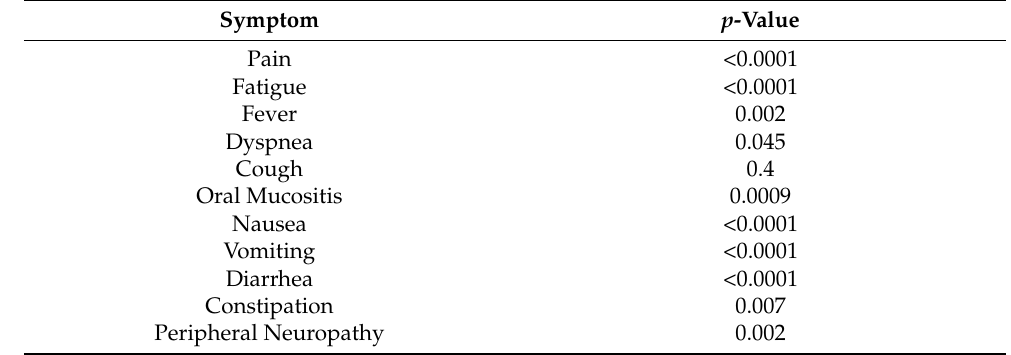
Table 3. Association between symptom change and QLQ-C30 change (responsiveness). (Abbrevia- tions: QLQ-C30-European Organisation for Research and Treatment of Cancer Core Quality of Life Questionnaire, version 3.0).